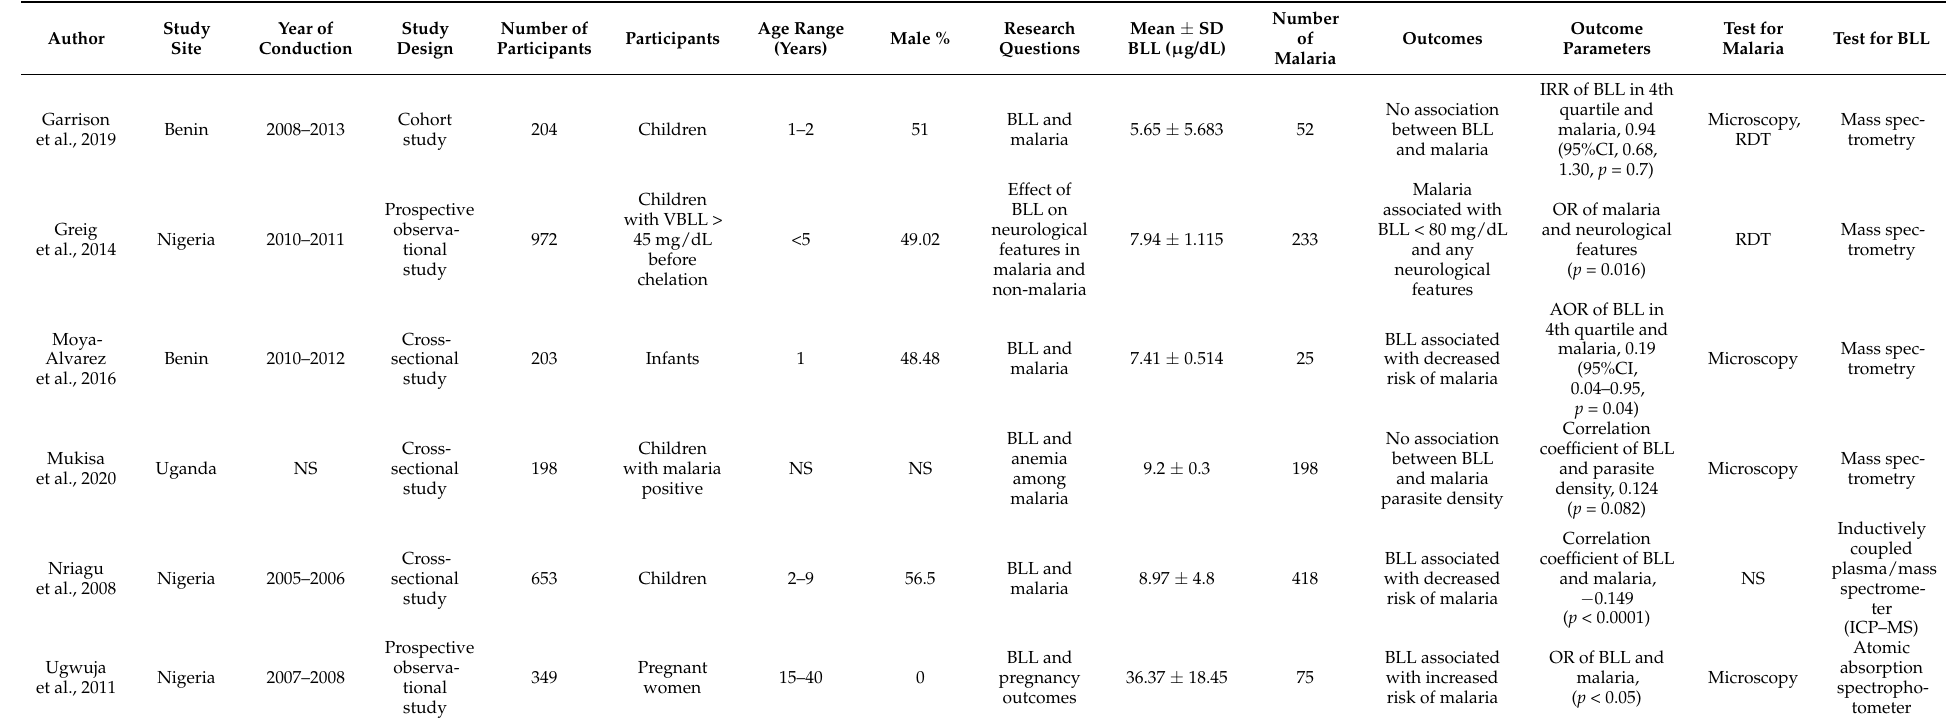
Table 1. Characteristics of the included